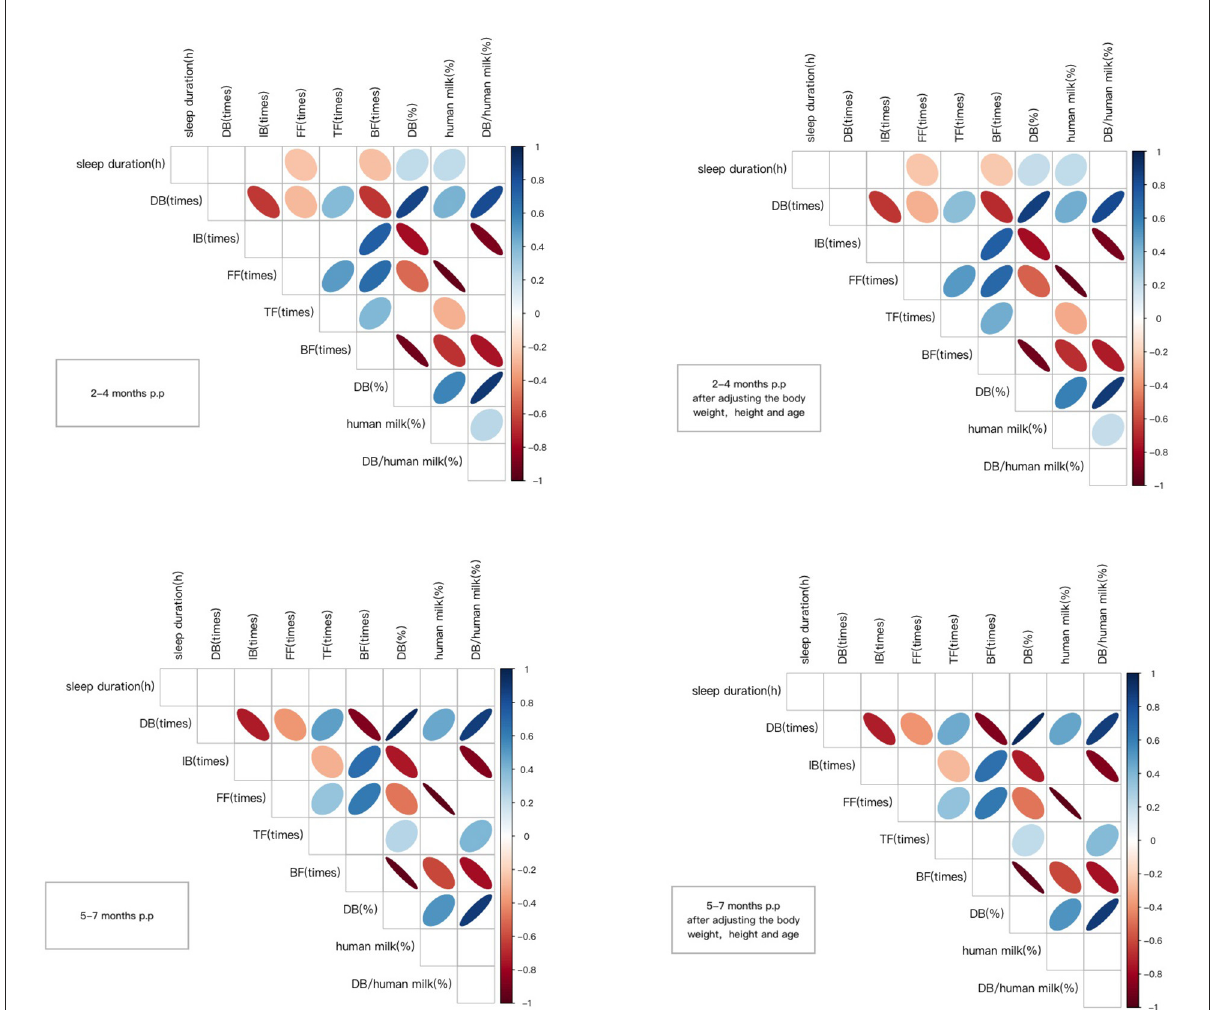
FIGURE4 Correlation coefficients between the variables . Only significant correlations are shown ( p < 0.05) either in blue (positive) or in red (negative). The Color intensity and size of the ellipse are proportional to the correlation coefficients. DB (times), refers to the frequency of direct breastfeeding per day; IB (times), refers to the frequency of indirect breastfeeding per day, generally referring to feeding the mother’s milk through bottles or other containers; FF (times), refers to the frequency of formula feeding per day; TF (times), refers to the frequency of total feeding per day, including breastfeeding and formula feeding; BF (times), refers to the frequency of bottle feeding per day, including feeding the mother’s milk through bottles and formula feeding; DB (%), refers to the percentage of the frequency of direct breastfeeding in the frequency of total feeding per day; human milk (%), the percentage of the frequency of human milk breastfeeding in the frequency of total feeding per